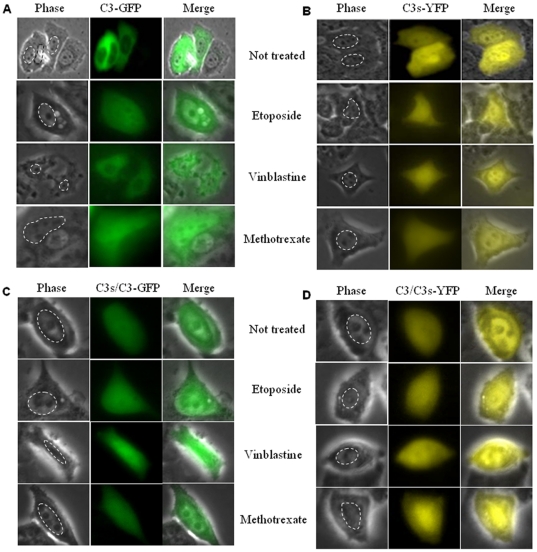
Caspase-3s influences the localization of procaspase-3.Twenty-four hours after GFP-coupled procaspase-3 (C3-GFP) or YFP-coupled caspase-3s (C3s-YFP) transfection in parental MCF-7 cells (A and B respectively) or in non tagged caspase-3s (C3s) or procaspase-3 (C3) stably transfected MCF-7 cells (C and D respectively) MCF-7 cells were treated or not with etoposide, vinblastine or methotrexate for 10 hours. Cells were scanned in phase contrast and with a GFP or YFP filter under UV light. Nuclei were delimited by dotted lines. The nulear staining quantification is presented in Table S4.